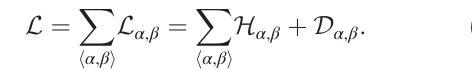
A is given by the ¼ tr A † j j j of the iPEPO tensor A used to j j . (e) Hilbert-Schmidt j of the tensor a HS used in constructing j j